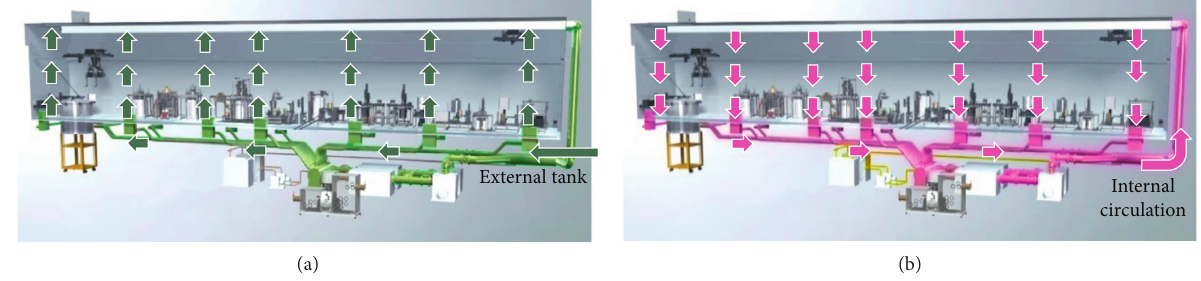
Figure 4: Argon flow for (a) initial purging and (b) regular